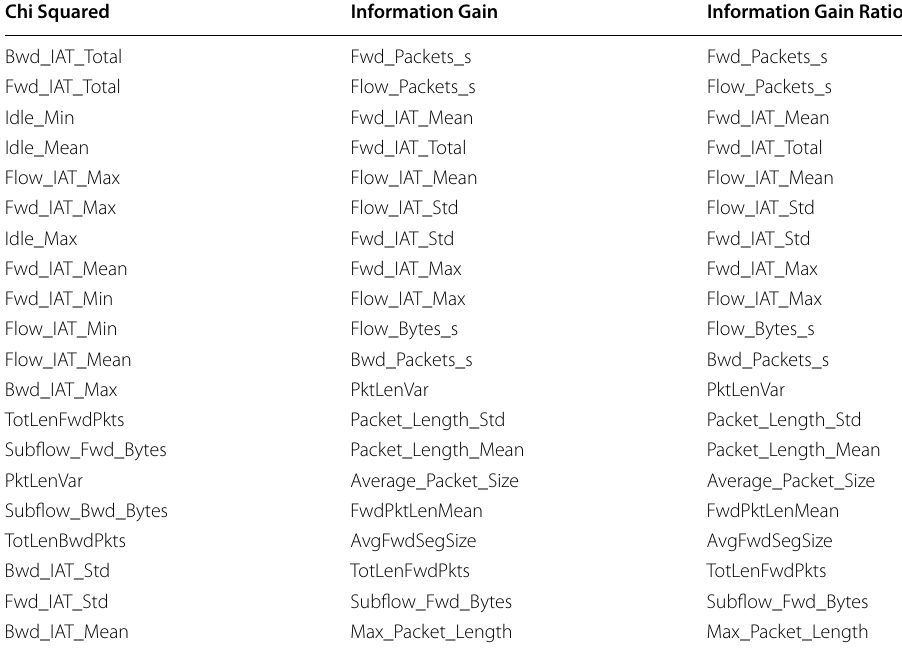
Table 18 Top 20 features for XSS web attacks ranked by Filter-based techniques Chi Squared